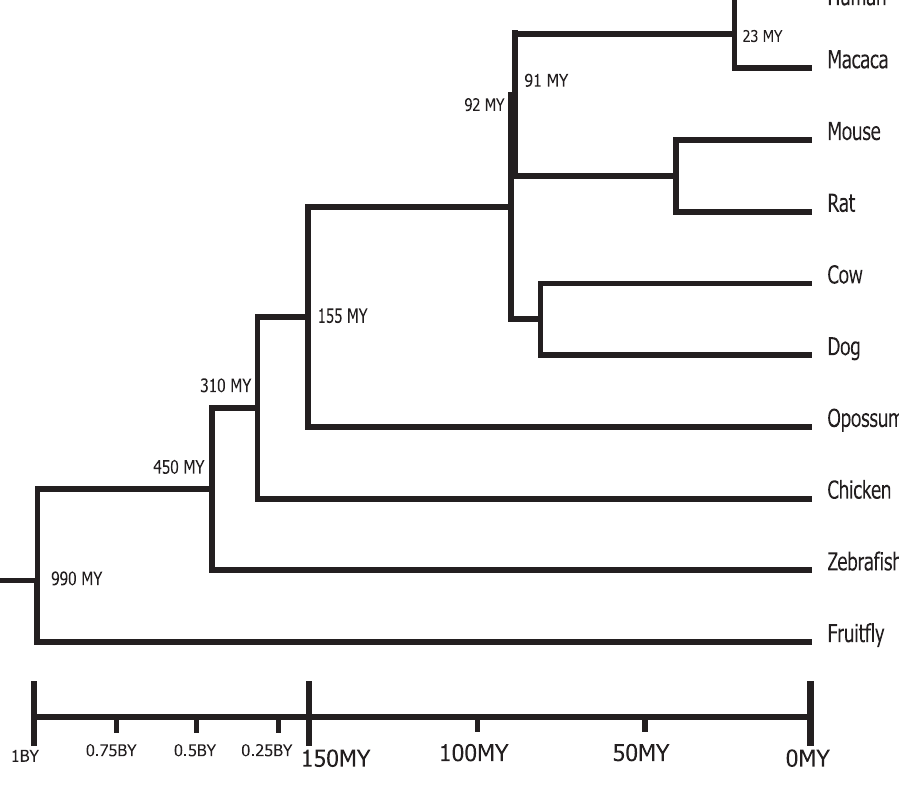
Figure 1. Species tree with divergence times. doi:10.1371/journal.pone.0007342.g001 PLoS ONE |